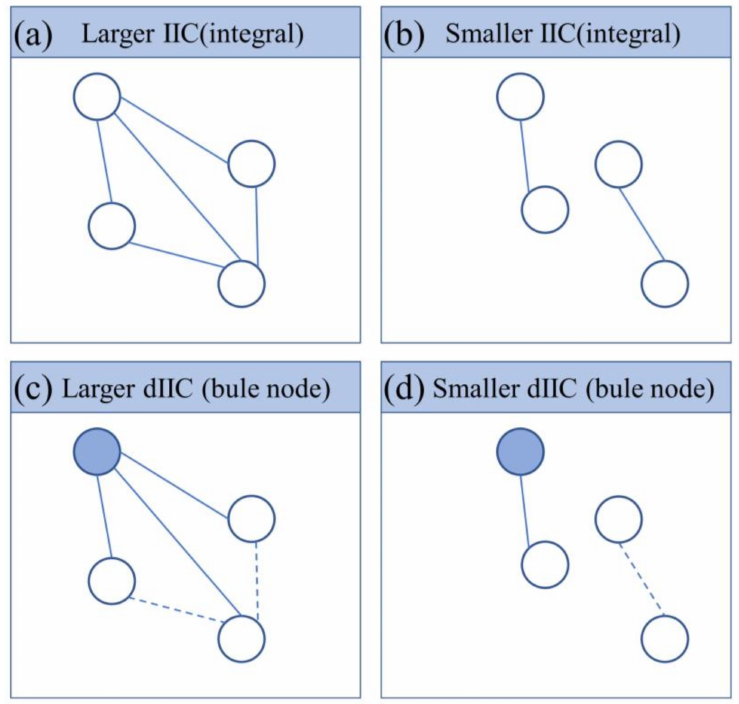
Figure 2. Different cases illustrating these two connectivity indexes. ( a ) Larger IIC: any two nodes are connecting. ( b ) Smaller IIC: pairwise connecting. ( c ) Larger dIIC for bule node: key node. ( d ) Smaller dIIC for bule node: non-key